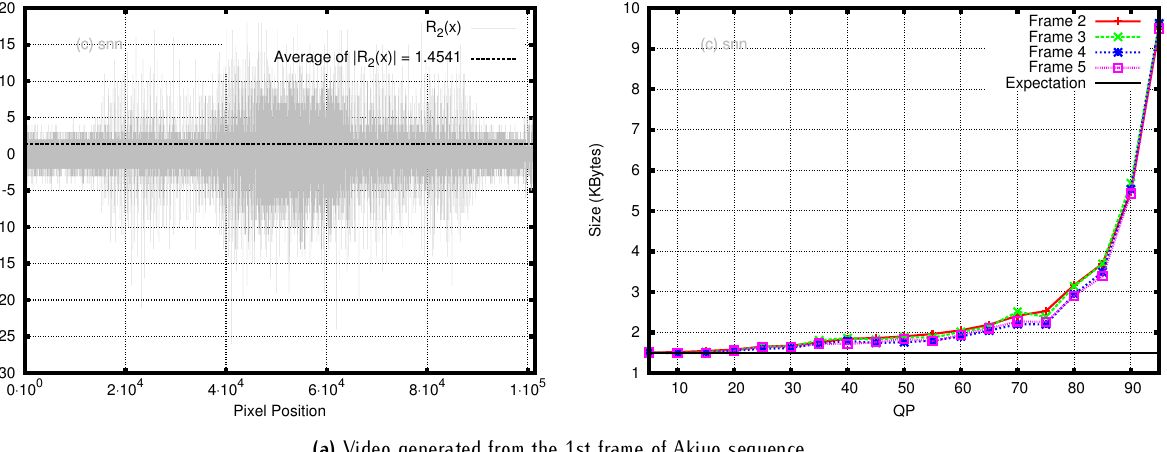
(a) Video generated from the 1st frame of Akiyo sequence.